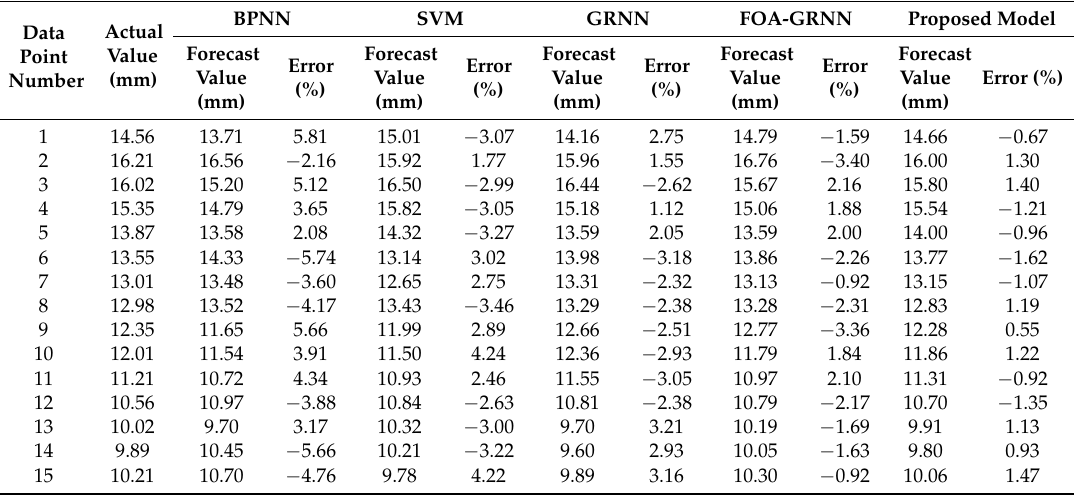
Table 5. Part of the forecasting value and relative errors of each